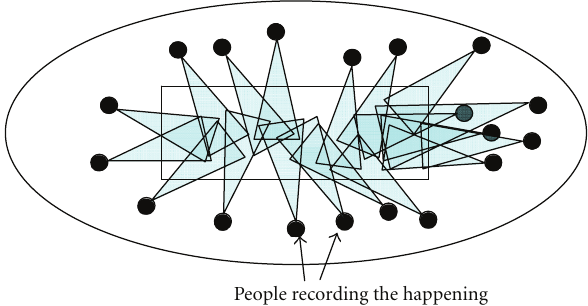
Figure 3: View from the top of a public event (live musical performance) with Nonelliptical layout (nonstadium).